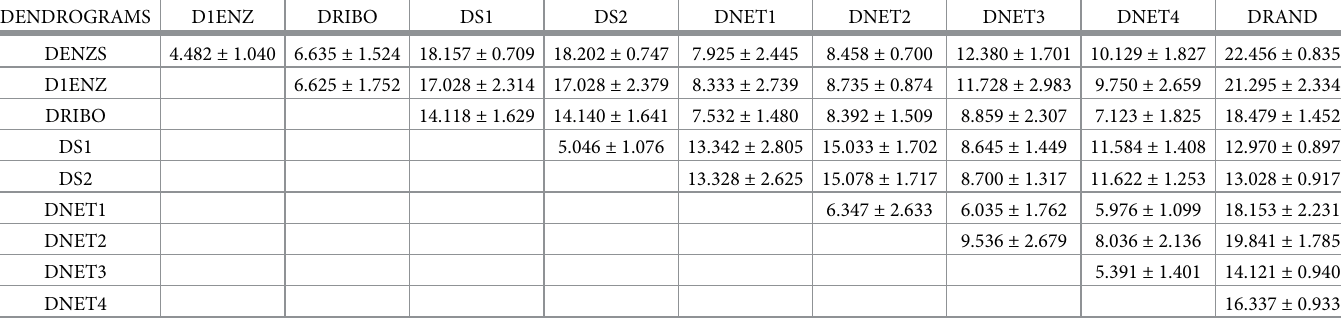
Table 3. Comparison of different gene-based and network dendrograms for the second ensemble (10 sets of 30 organisms in each set).